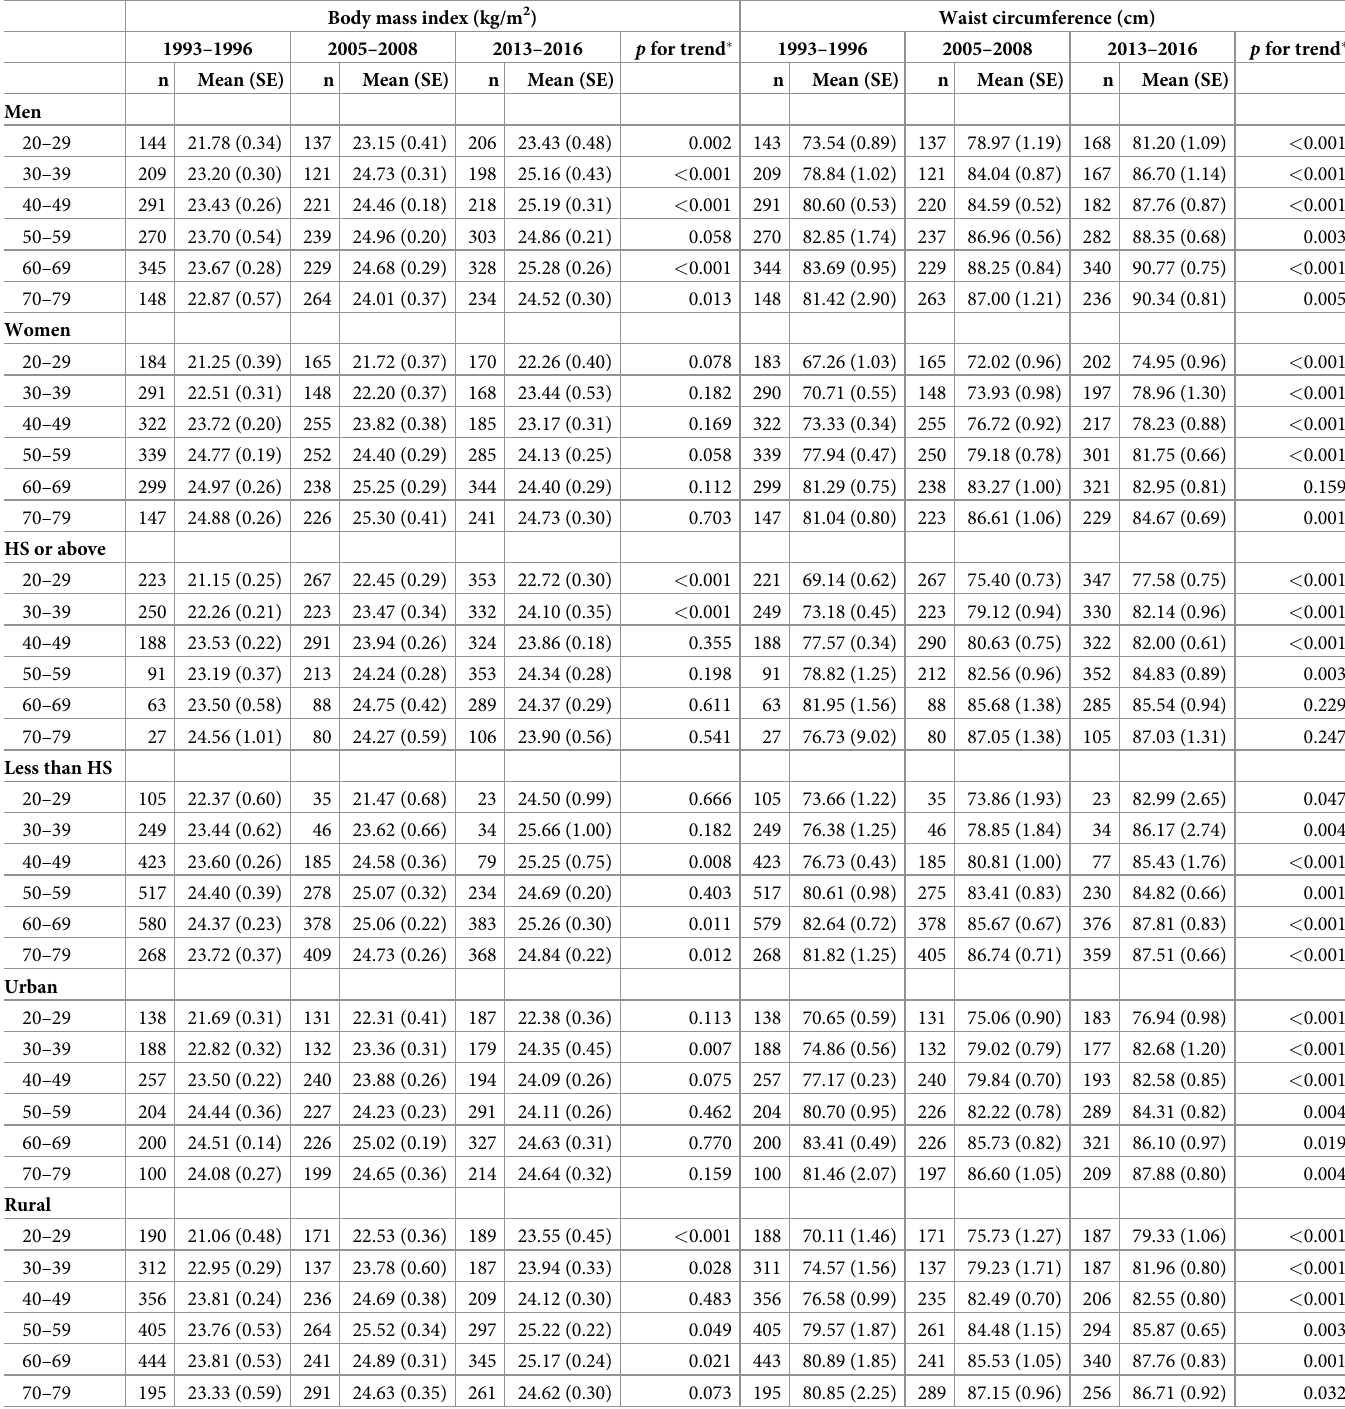
� Linear trends in the mean body mass index and waist circumference were tested using linear regression model. HS = high school, NAHSIT = Nutrition and Health Survey in Taiwan, SE = standard